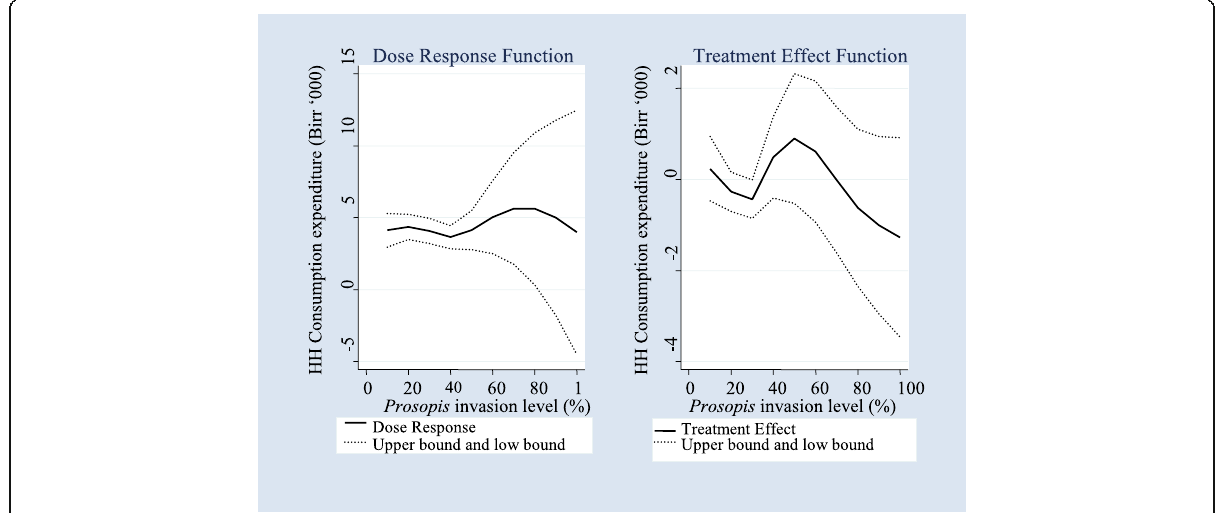
Figure 3 Estimated average dose-response function, estimated derivative, and 5% confidence bands for household consumption expenditure (Quadratic). HH,